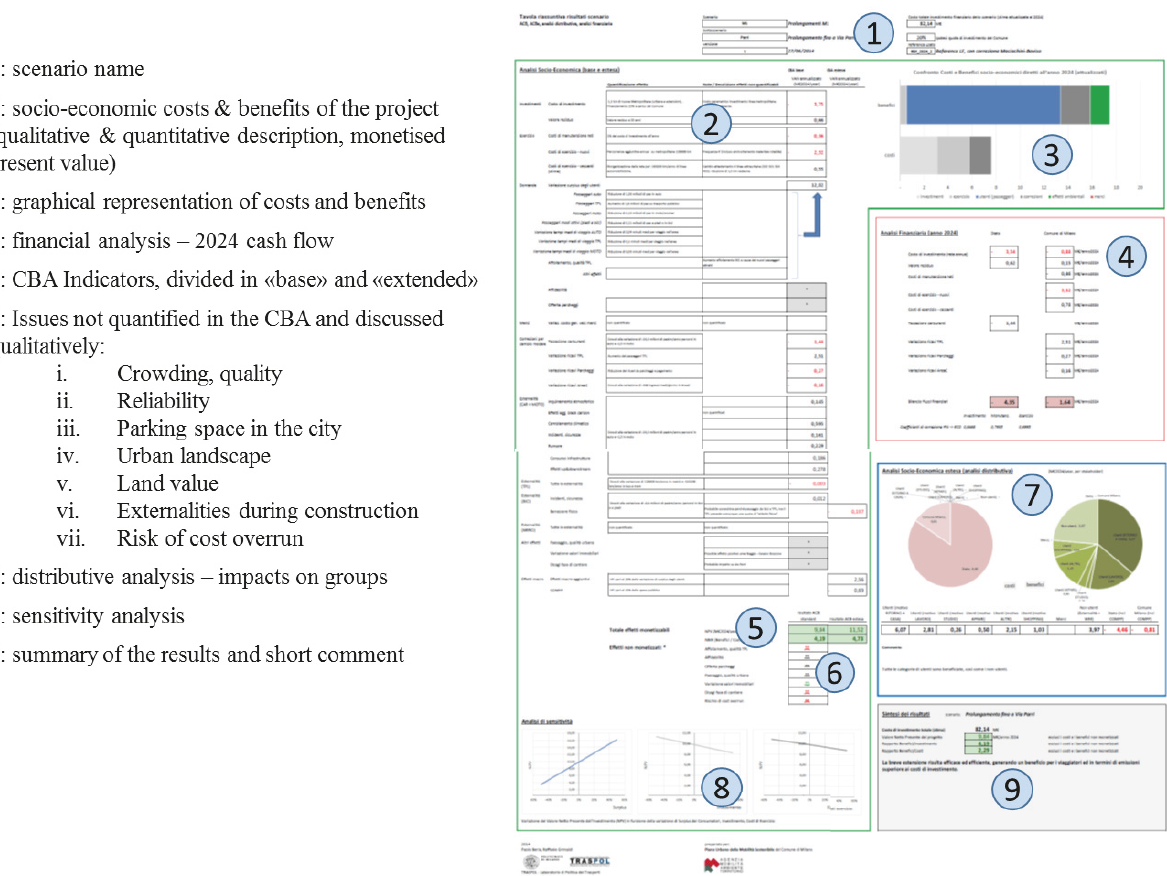
Figure 4: An example of Appraisal Summary Table